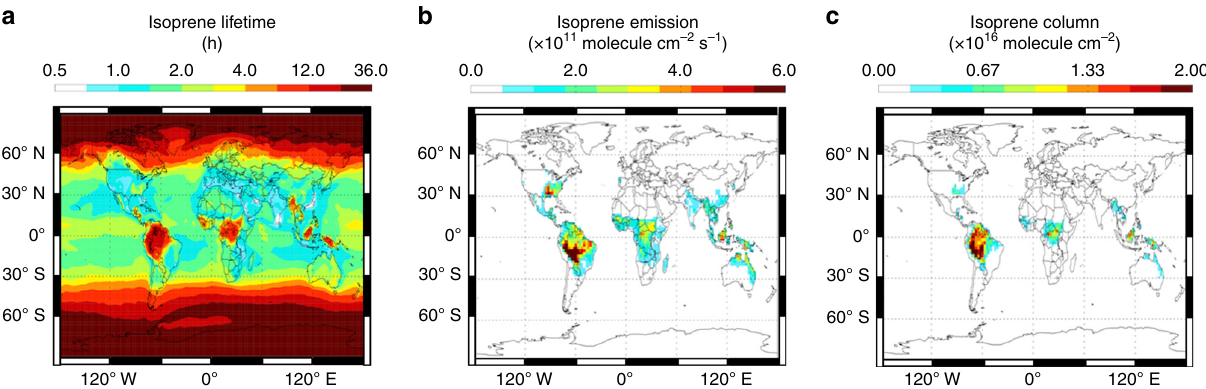
Fig. 6 Global distribution of isoprene lifetime ( a ), emissions ( b ), and column abundance ( c ) as simulated by the GEOS-Chem model for September 2013. All data is mapped on a 2.5° × 2.0° latitude – longitude grid